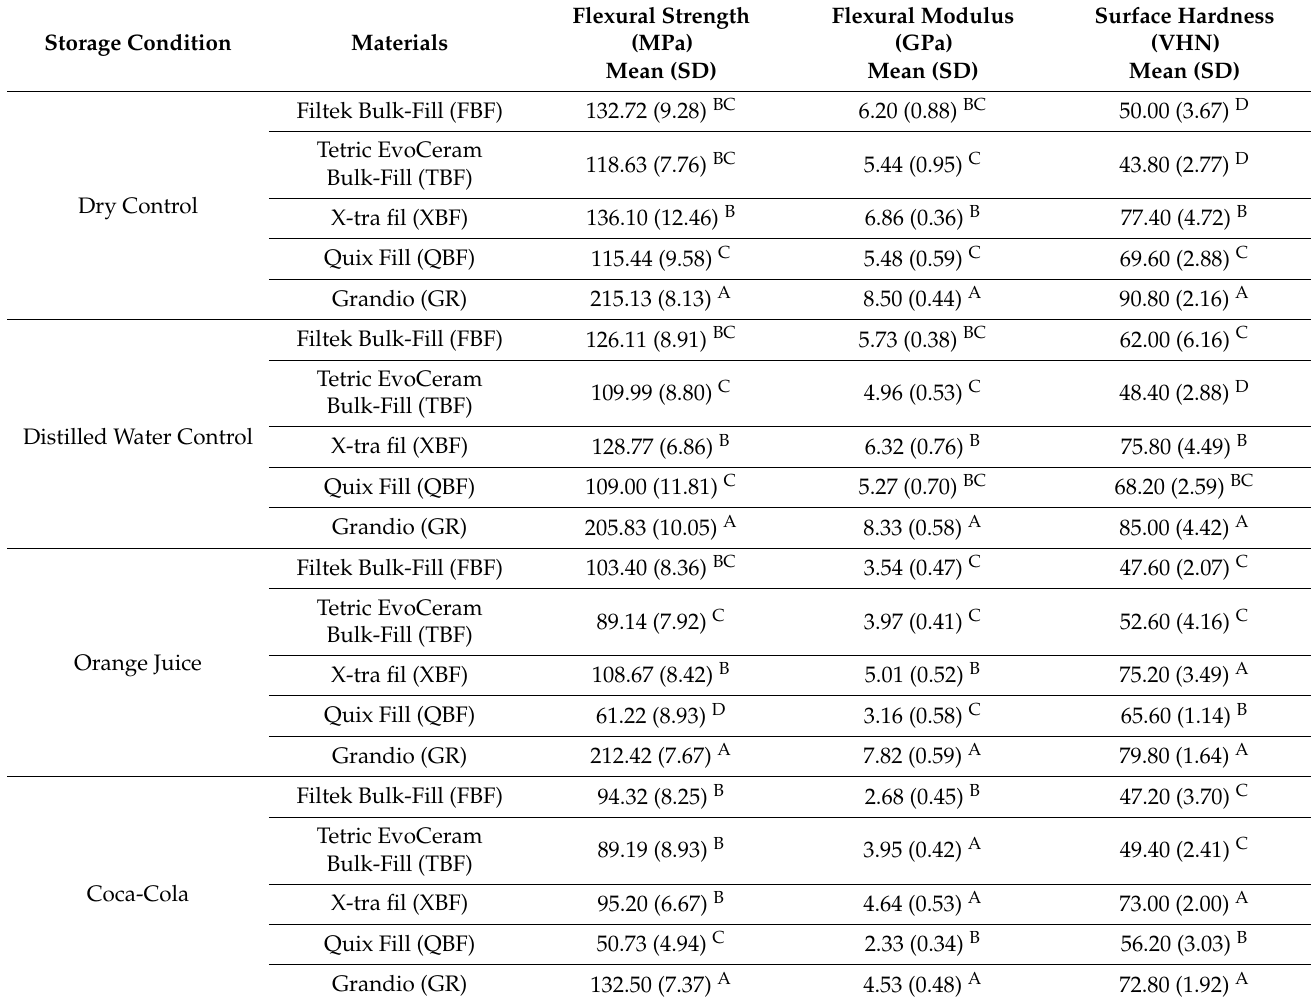
Table 3. The flexural strength, flexural modulus, and surface hardness of all RBCs under each storage condition.